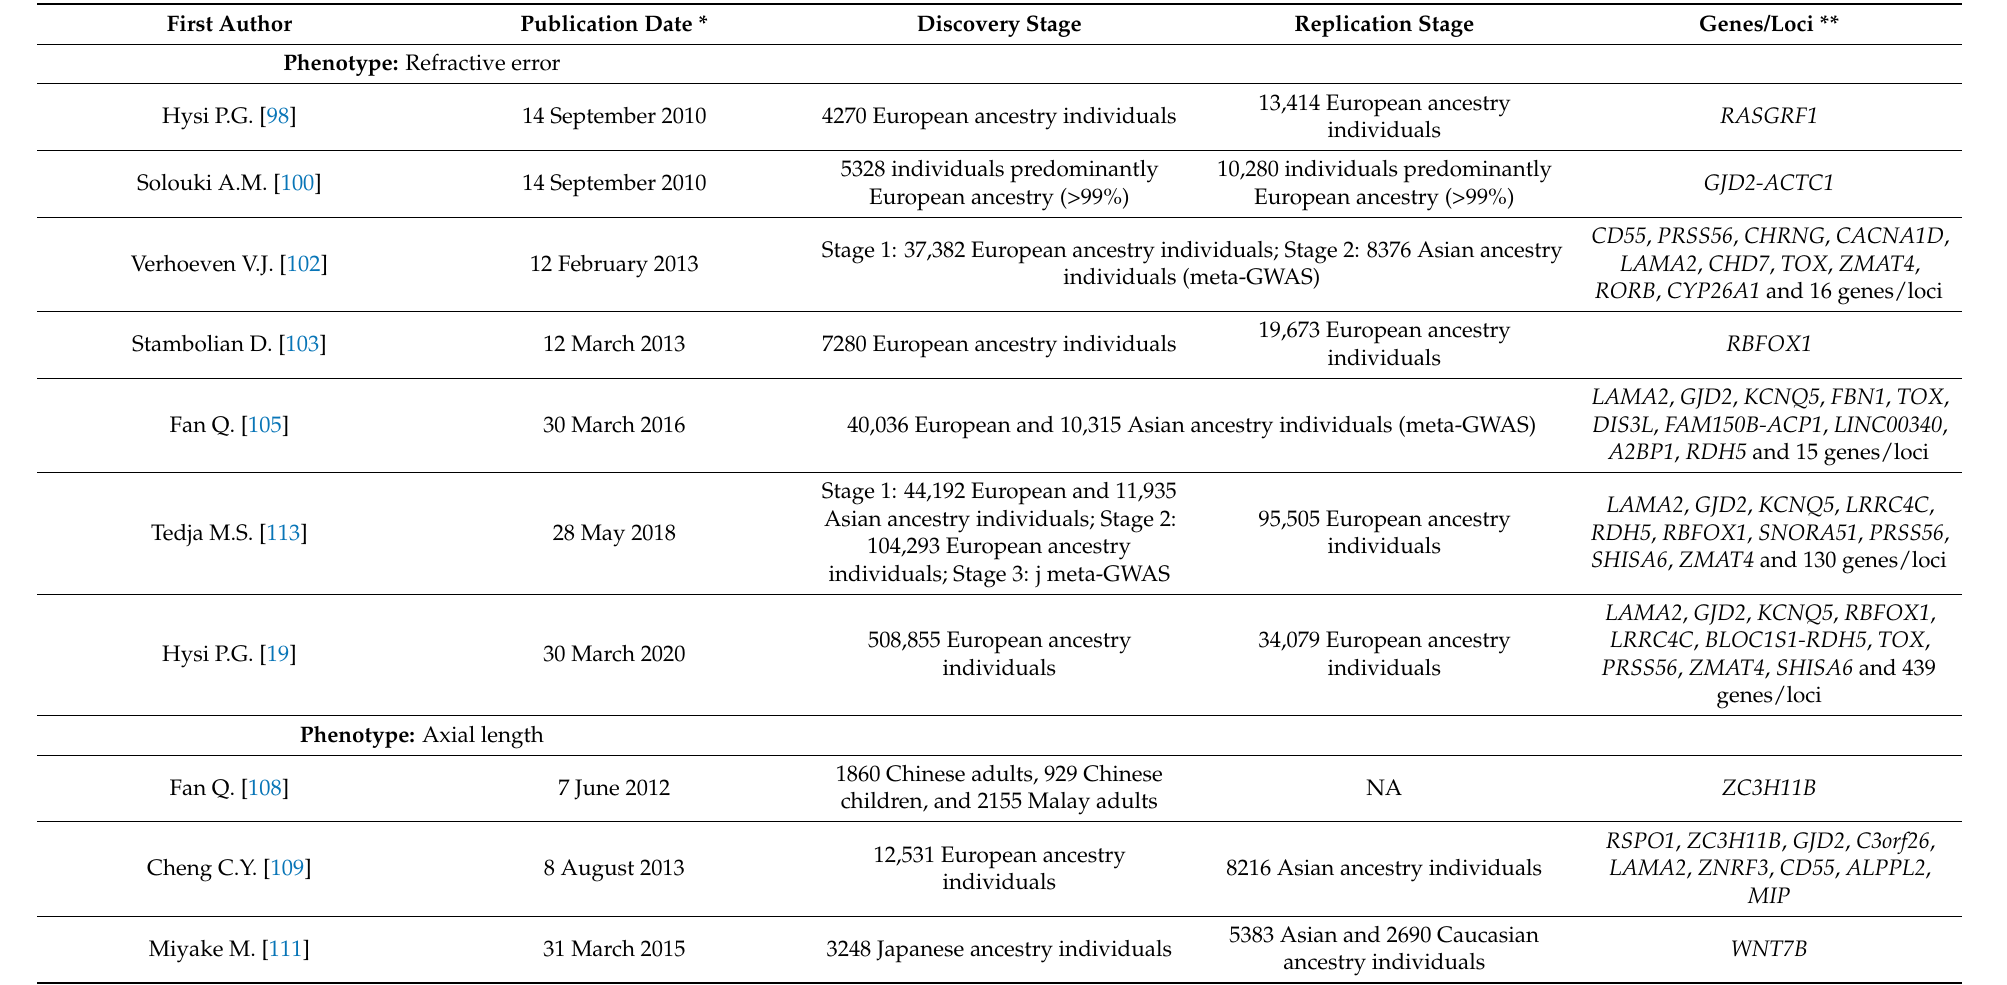
Table 3. Genome-wide association studies in refractive error and axial